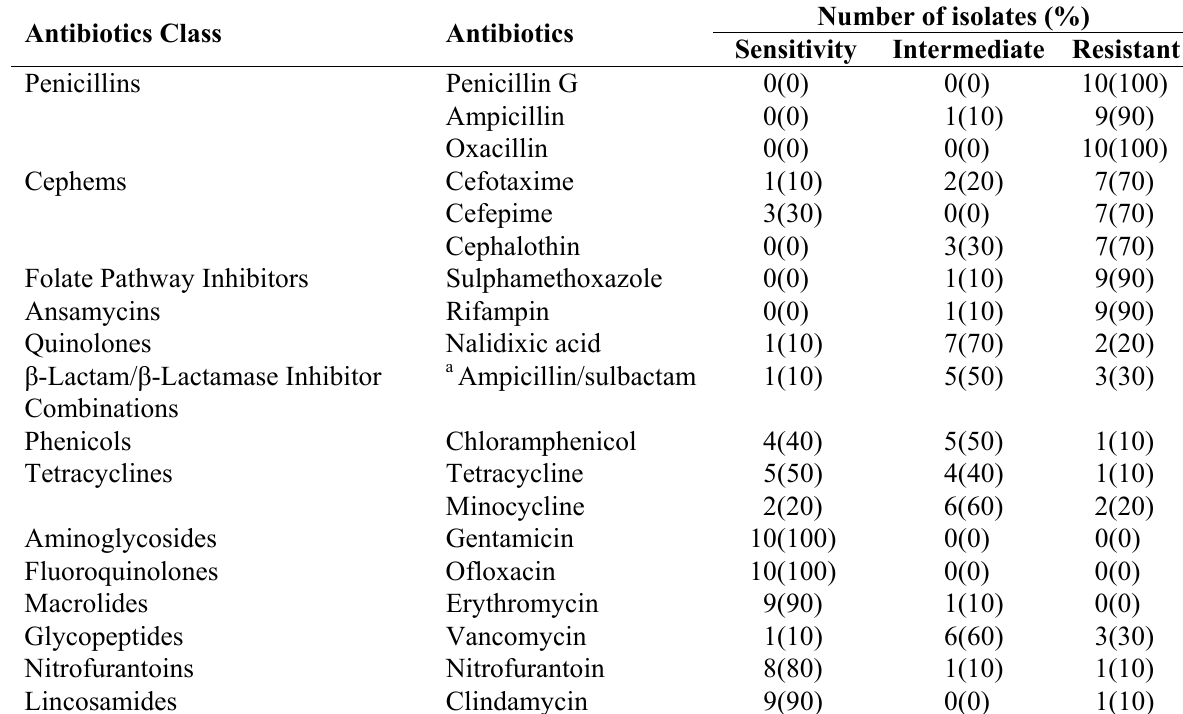
Table 2. Antibiogram of randomly selected Pseudomonas isolates from the final effluents of the three wastewater treatment plants.